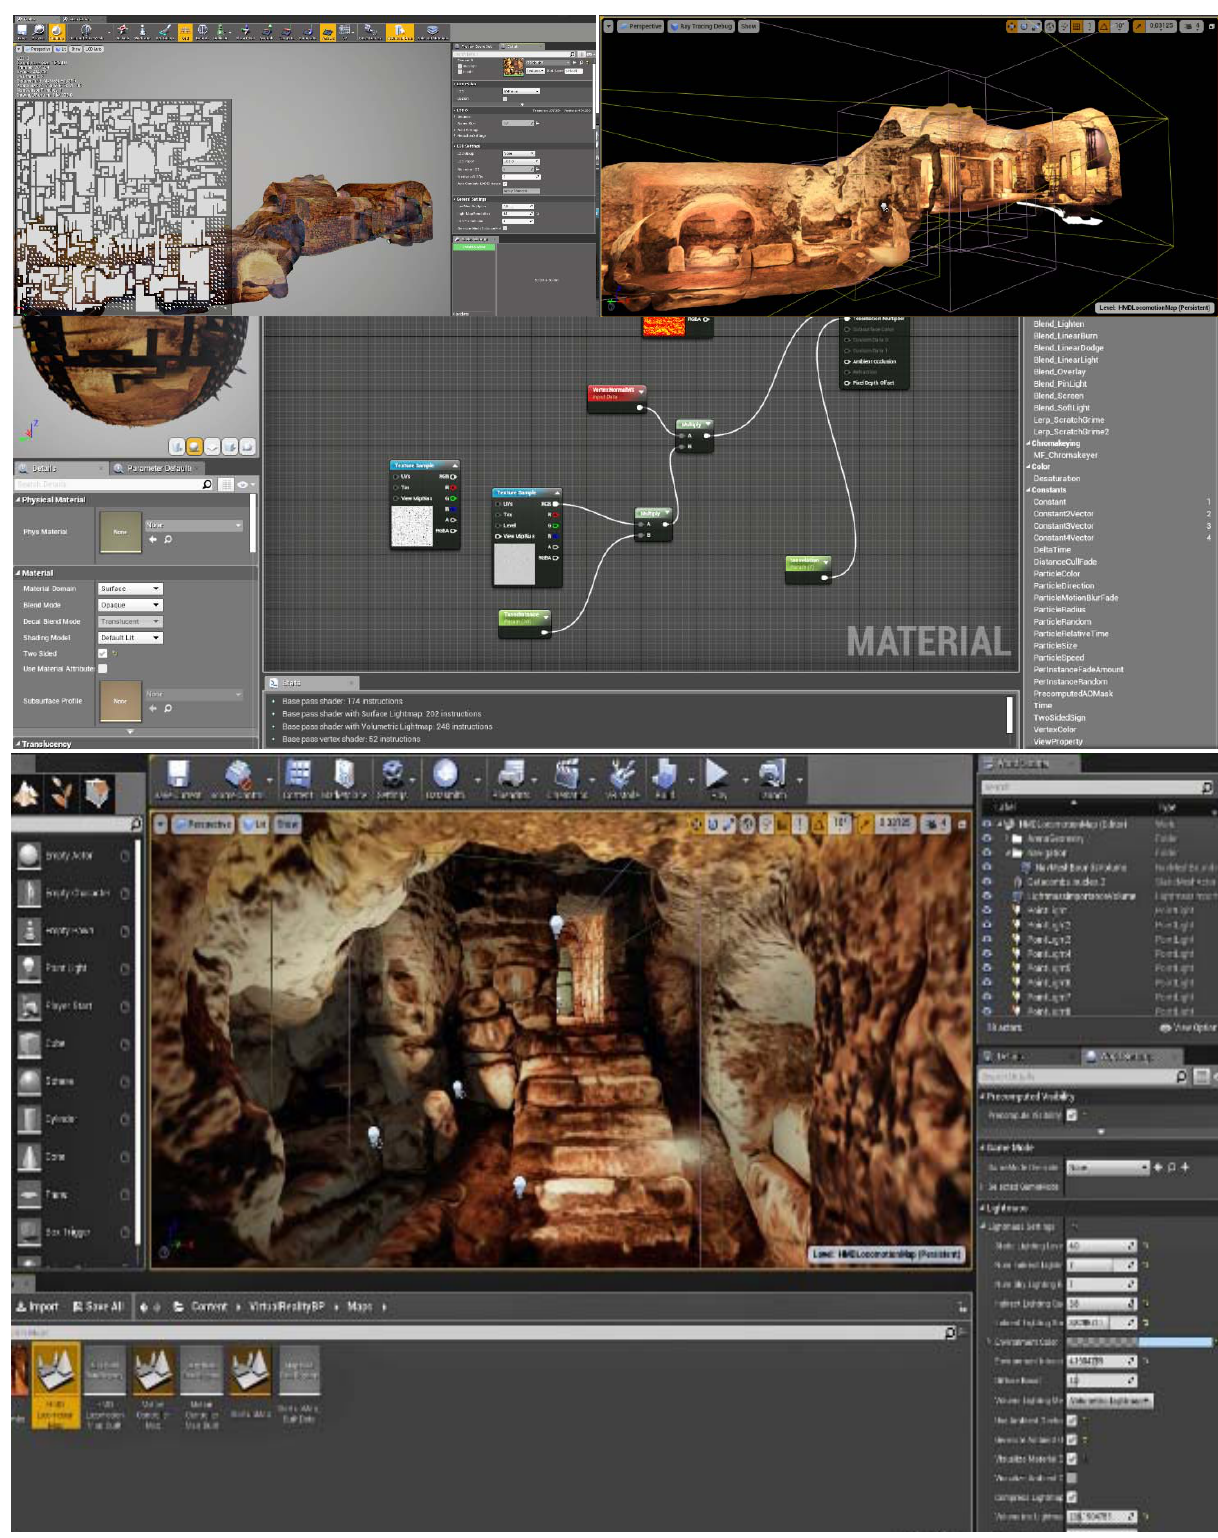
Figure 8. Unreal Engine 4.22 interface, construction of the virtual tour and structure of the Path Tracing lighting in real time, conversion for Oculus